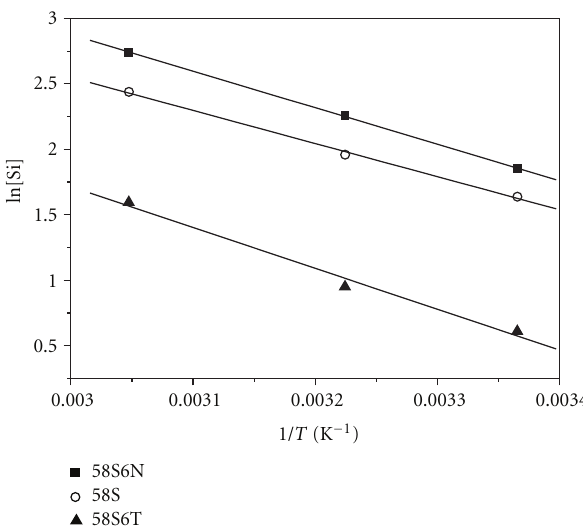
Figure 2: Arrhenius plots for the release of Si ions from di ff erent bioactive glasses.